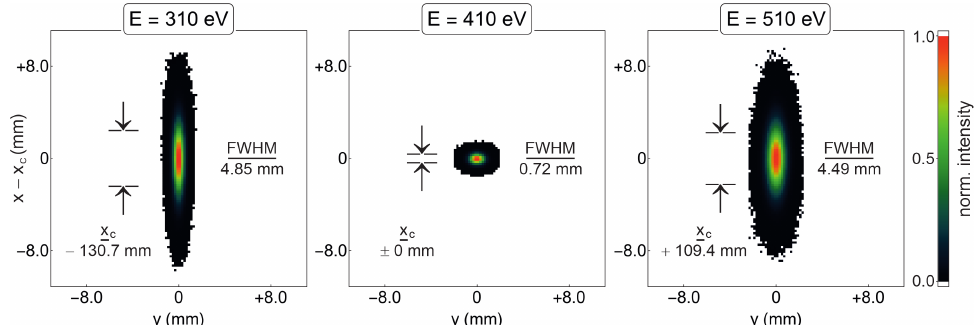
Figure 4. Footprint of the pulsed beam on the PM at three photon energies, evaluated from RT simulations for a source size ∅ src = 50 µ m and a divergence ∆ ϑ = 1mrad. The meridional width (FWHM) and the central position x c of the spot on the PM (see Figure 1 and text for details) are noted.